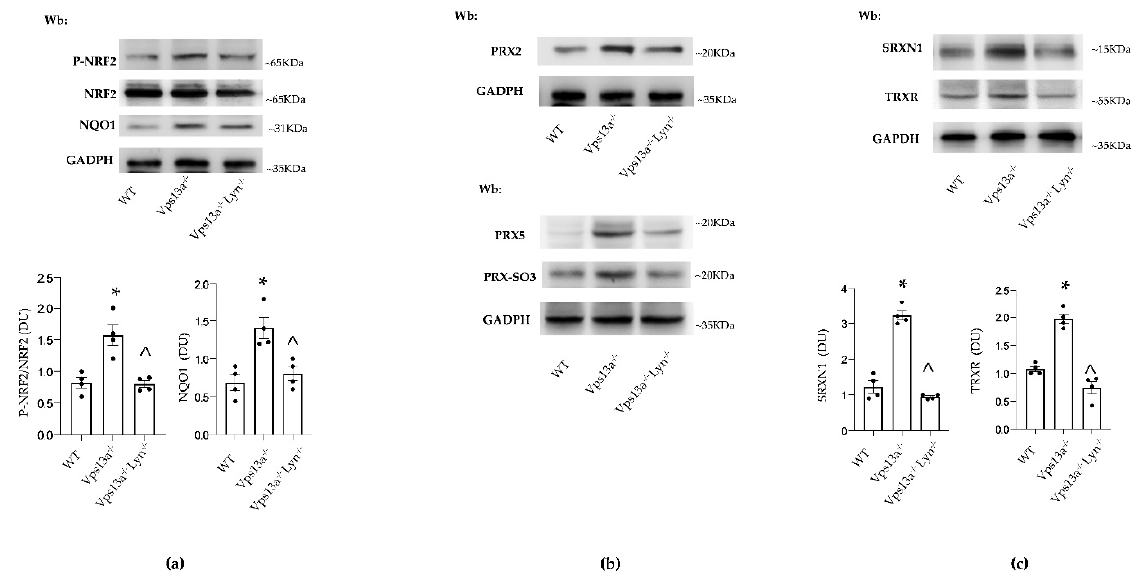
Figure 4. ( a ) Western blot (Wb) analysis of phospho-NRF2, total NRF2 and NQO1 in isolated basal ganglia from wild-type (WT), Vps13a − / − mice and Vps13a − / − ; Lyn − / − mice aged 12 months. GADPH was used as protein loading control. Representative of 4 blots with similar results. Densitometric analysis is shown in lower panel. Data are shown as means ± SEM, n = 4; * p < 0.05 compared to WT animals; ˆ p < 0.05 compared to 12-month-old WT mice. ( b ) Western-blot (Wb) analysis of PRX2 (upper panel) and PRX5 and PRX-SO3 (lower panel) in isolated basal ganglia from wild-type (WT), Vps13a − / − mice and Vps13a − / − ; Lyn − / − mice aged 12 months. GADPH was used as protein loading control. Representative of 4 blots with similar results. Densitometric analysis is shown in Supplementary Figure S3. ( c ) Western-blot (Wb) analysis of sulfiredoxin 1 (SRXN1) and thioredoxin reductase (TRXR) in isolated basal ganglia from wild-type (WT), Vps13a − / − mice and Vps13a − / − ; Lyn − / − mice aged 12 months. GADPH was used as loading control. Representative of 4 blots with similar results. Densitometric analysis is shown in lower panel. Data are shown as means ± SEM, n = 4; * p < 0.05 compared to WT animals; ˆ p < 0.05 compared to 12-month-old WT mice.